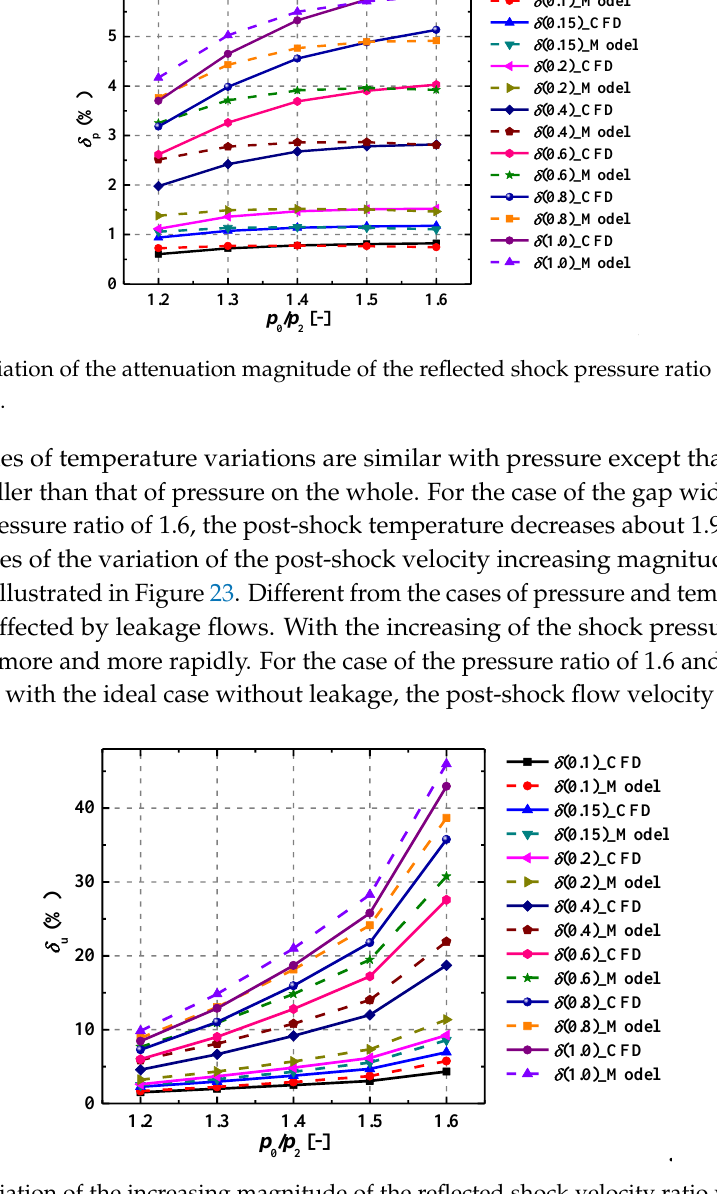
Figure 23. Variation of the increasing magnitude of the reflected shock velocity ratio with the ideal shock strength.